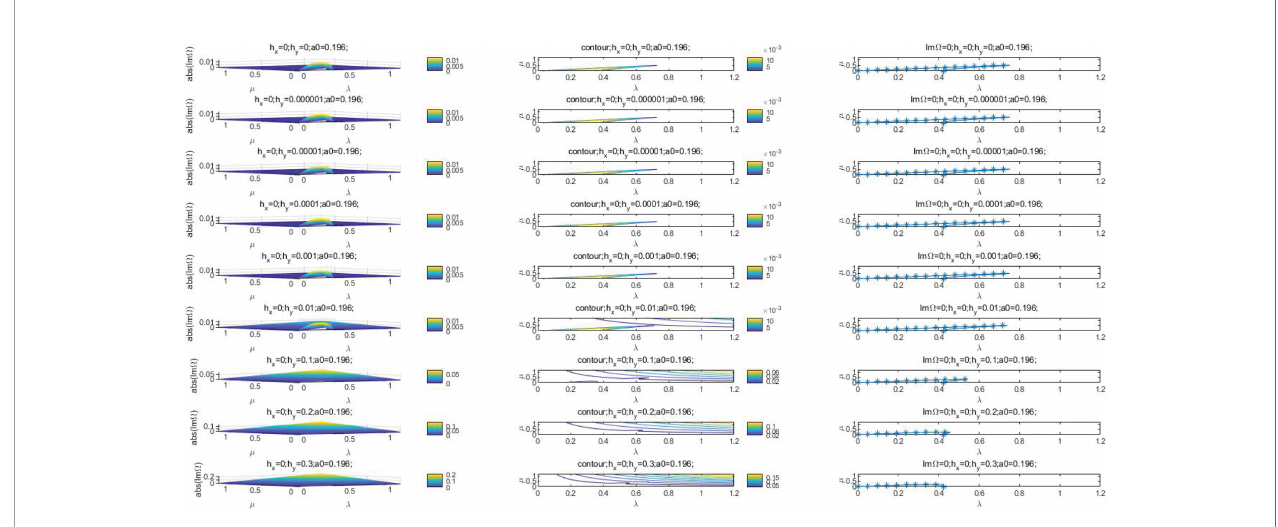
FIGURE 1 | Curves of ǀ Im W ǀ and Im W = 0 for a 0 = 0.196 and ∂ h ∂ x =